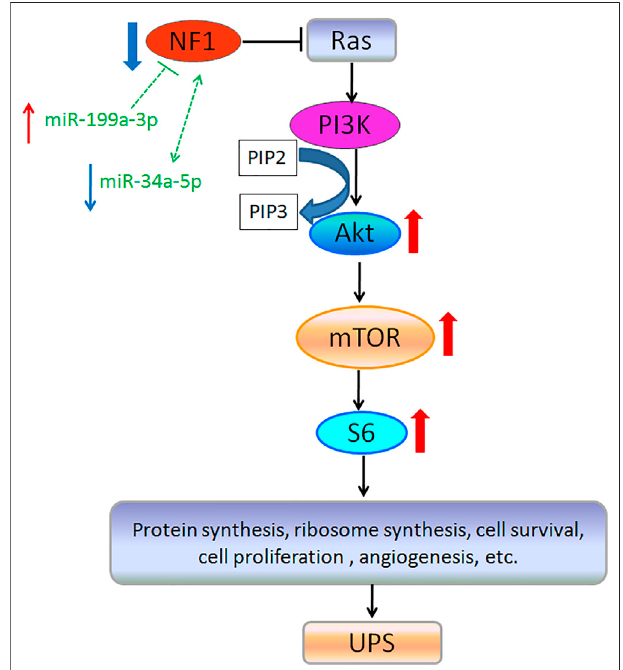
FIGURE6| ConclusionimageofNF1 andNF1-related miRNAsinvolved insignalpathwaysandoccurrenceofUPS.Note:Bluearrows:downregulated expression; Red arrows: upregulated expression; and Dotted line: Need to be